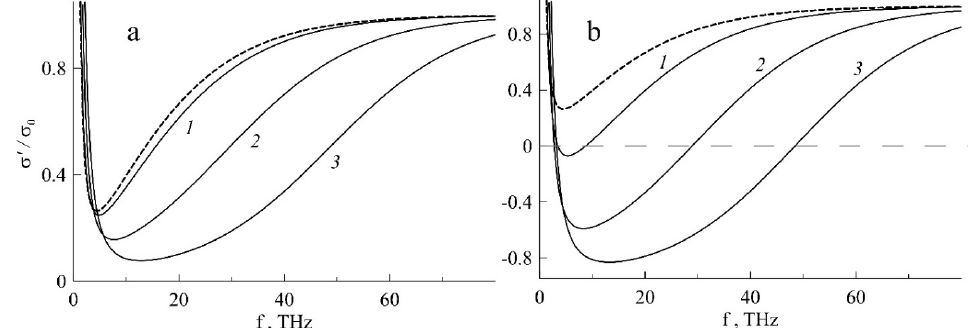
Figure 2. Frequency dependence of the conductivity real part of doped and inverted graphenes ( a , b ); 0; 0.02; 0.06; 0.10 eV (dashed curve and curves